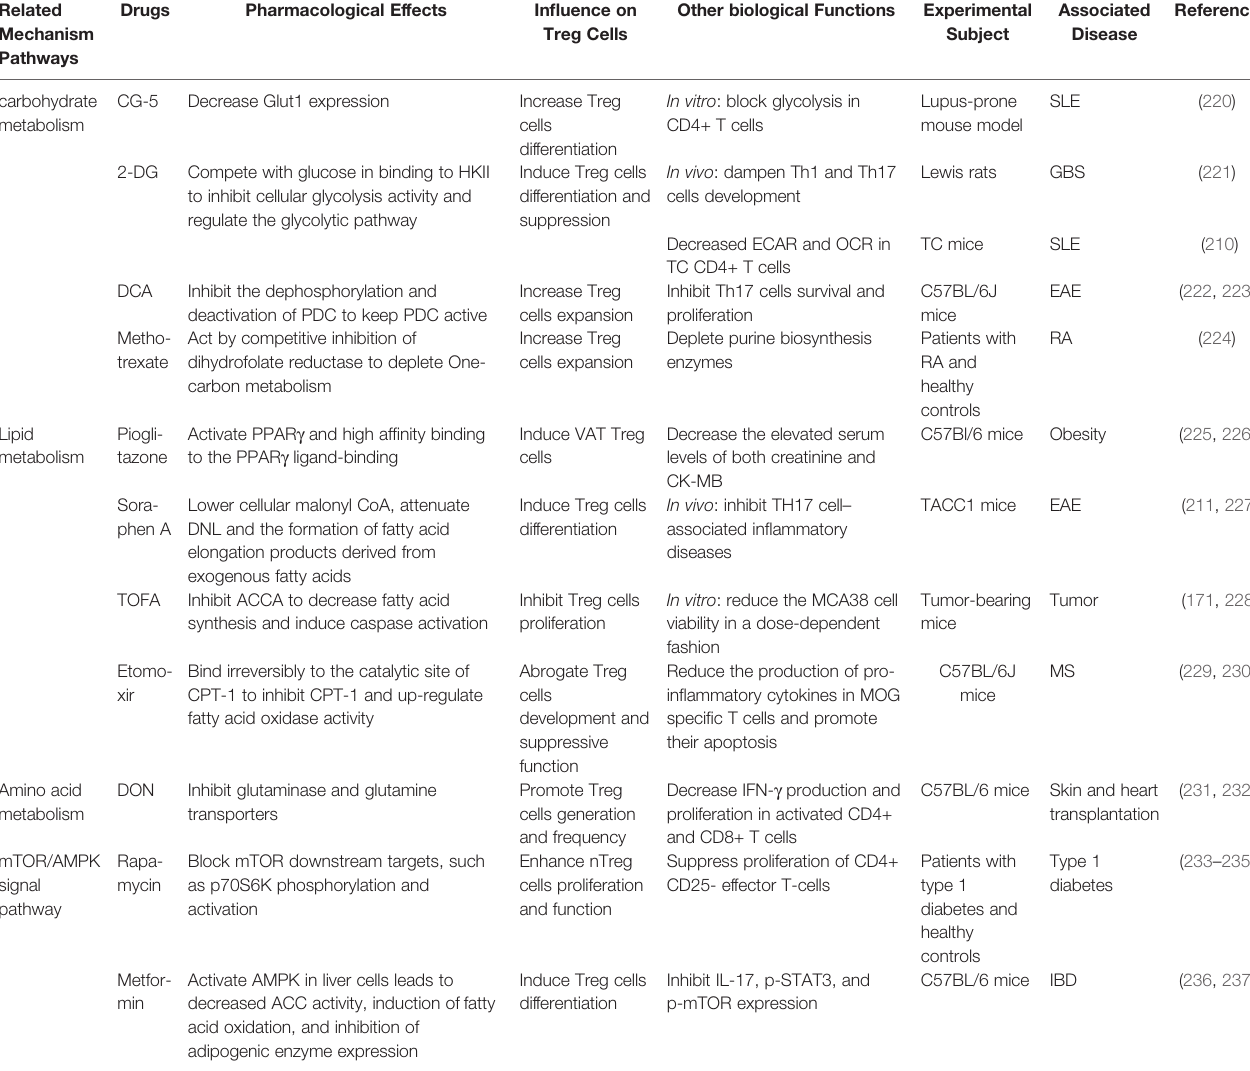
TABLE 1 | Inhibitors of the metabolic pathways, their in fl uence on Treg cells and disease applied. Related